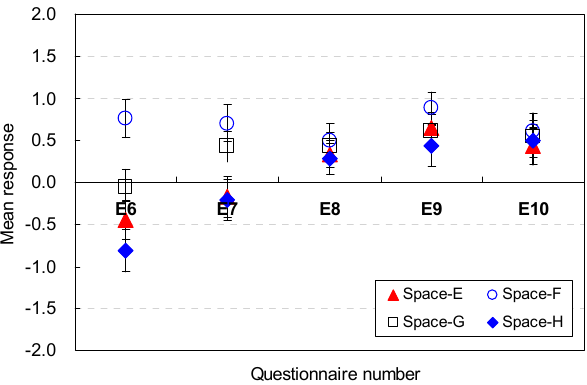
Figure 14. Spatial perception of the spatial shape in terms of efficiency under height changes.